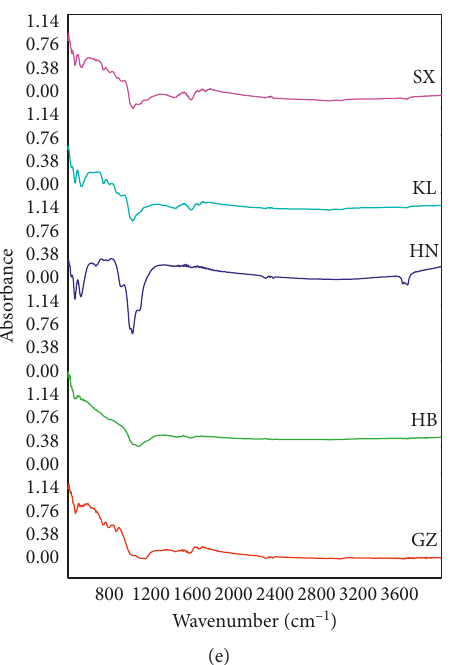
Figure 5: In situ infrared spectra of five coal samples at the same temperature: (a) 100 ° C; (b) 200 ° C; (c) 300 ° C; (d) 400 ° C; (e) 500 °